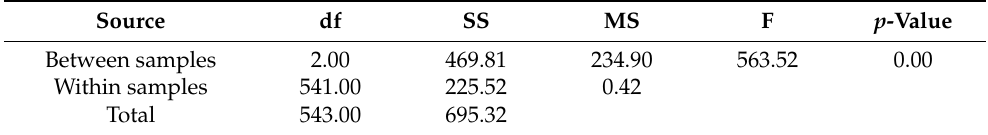
Table 4. The ANOVA results for the model.